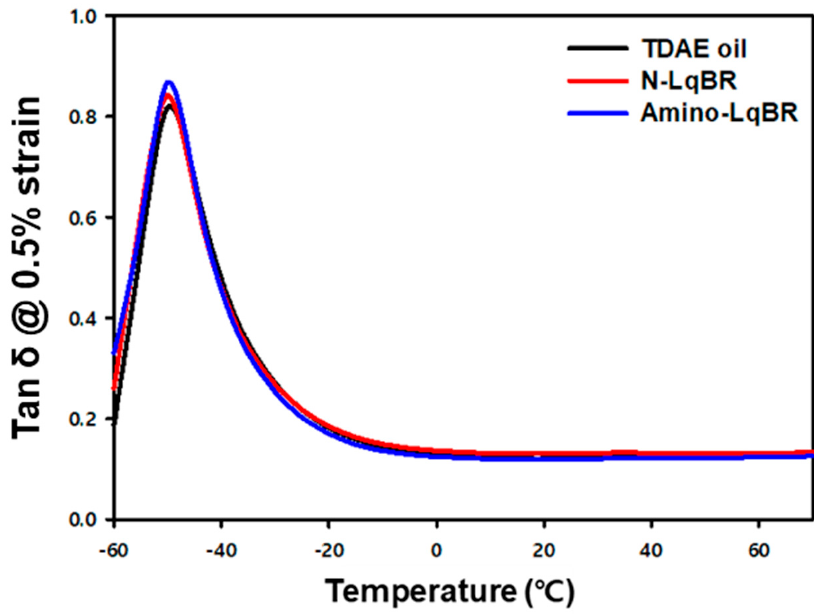
Figure 10. Tan δ curves of vulcanizates in the temperature sweep test. Table 9. Viscoelastic properties of vulcanizates.